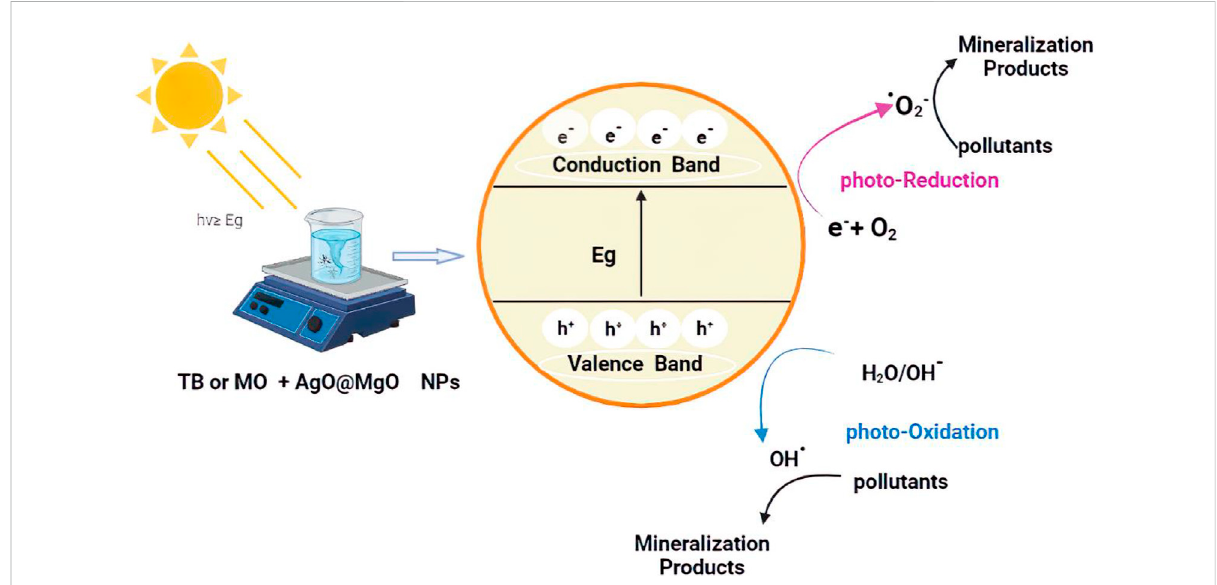
FIGURE 9 MB and TB photocatalytic mineralization mechanism on the surface of AgO/Ag 2 O and MgO@AgO/Ag 2